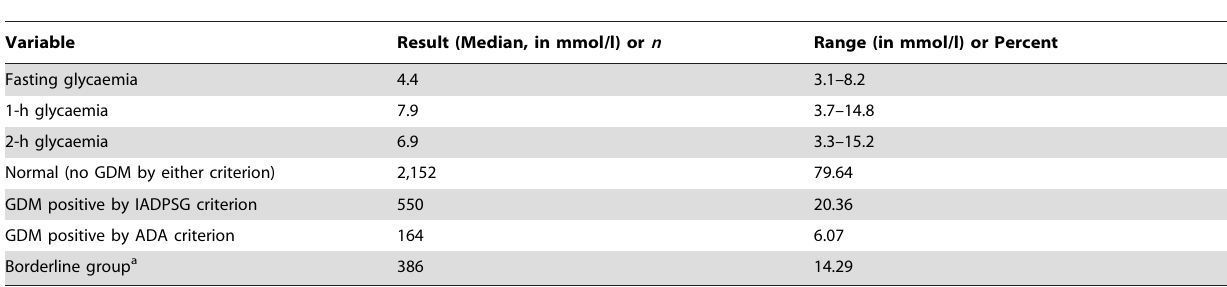
Table 2. Maternal glycaemia and prevalence of gestational diabetes.